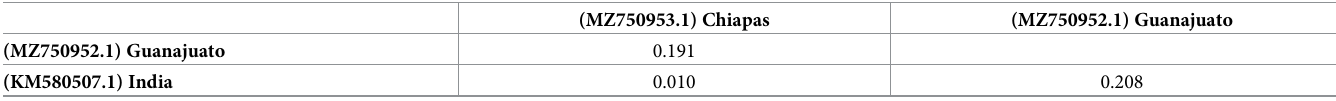
Table 4. Pairwise genetic distances. Calculations based on sequenced COI fragment.